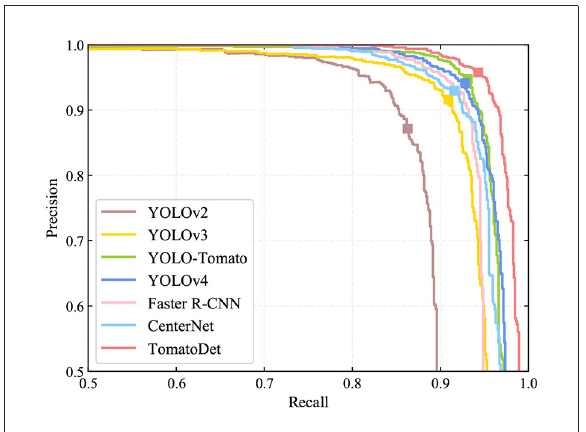
FIGURE8 PR curves of different detection